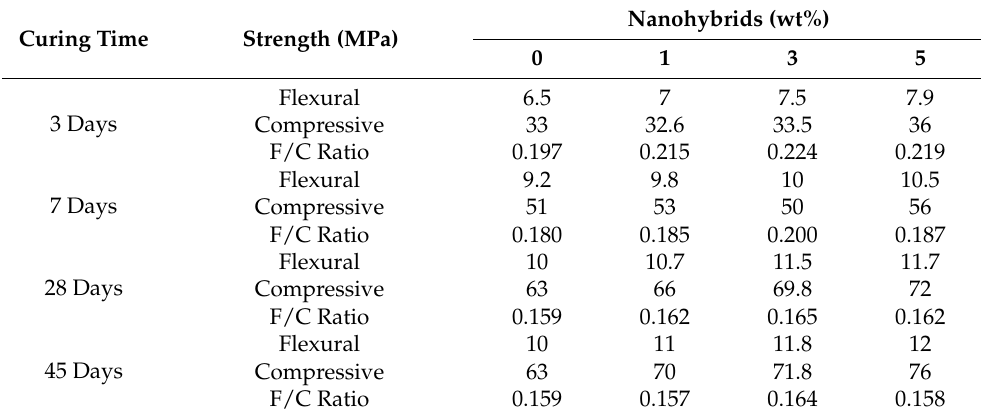
Figure 5. TEM micrographs of PU-MgO nanohybrids. Table 3. Flexural strength, compressive strength, and F/C ratio of the samples with different